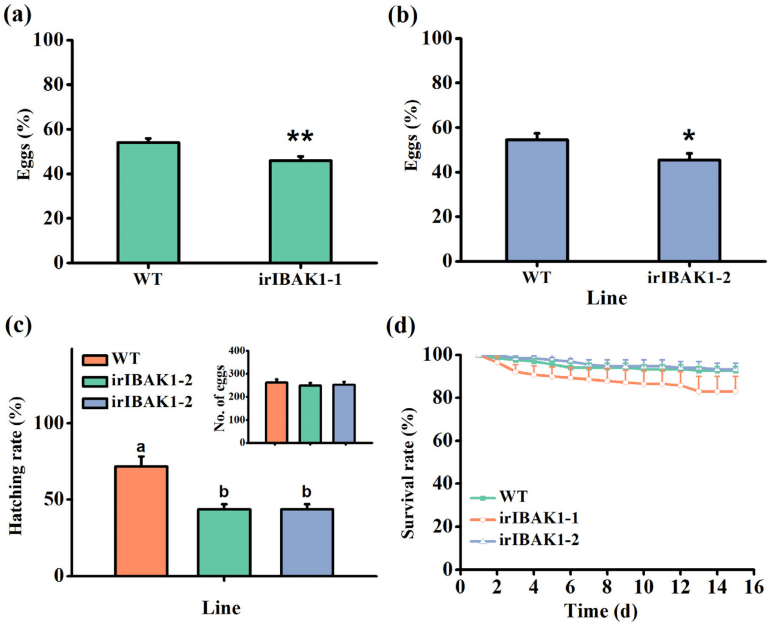
Figure 6. Silencing OsI-BAK1 enhances the resistance of rice to BPH. ( a , b ) Mean percentage (+SE, n = 10) of BPH eggs per plant on pairs of plants (WT versus irIBAK1-1 or irIBAK1-2) 48 h after the release of BPH. Asterisks represent significant differences between the WT and transgenic plants (irIBAK1-1 or irIBAK1-2) (* p < 0.05 and ** p < 0.01; Student’s t -tests). ( c ) Mean hatching rate (+SE, n = 10) of BPH eggs laid on WT and ir- ibak1 plants. Inserts: mean number of BPH eggs (+SE, n = 10) per plant on WT and ir- ibak1 plants. Different letters indicate significant differences among the lines ( p < 0.05, Tukey’s HSD post-hoc tests). ( d ) Mean survival rate (+SE, n = 10) of BPH nymphs on WT and ir- ibak1 plants 0–16 d after the newly hatched nymphs were placed on the